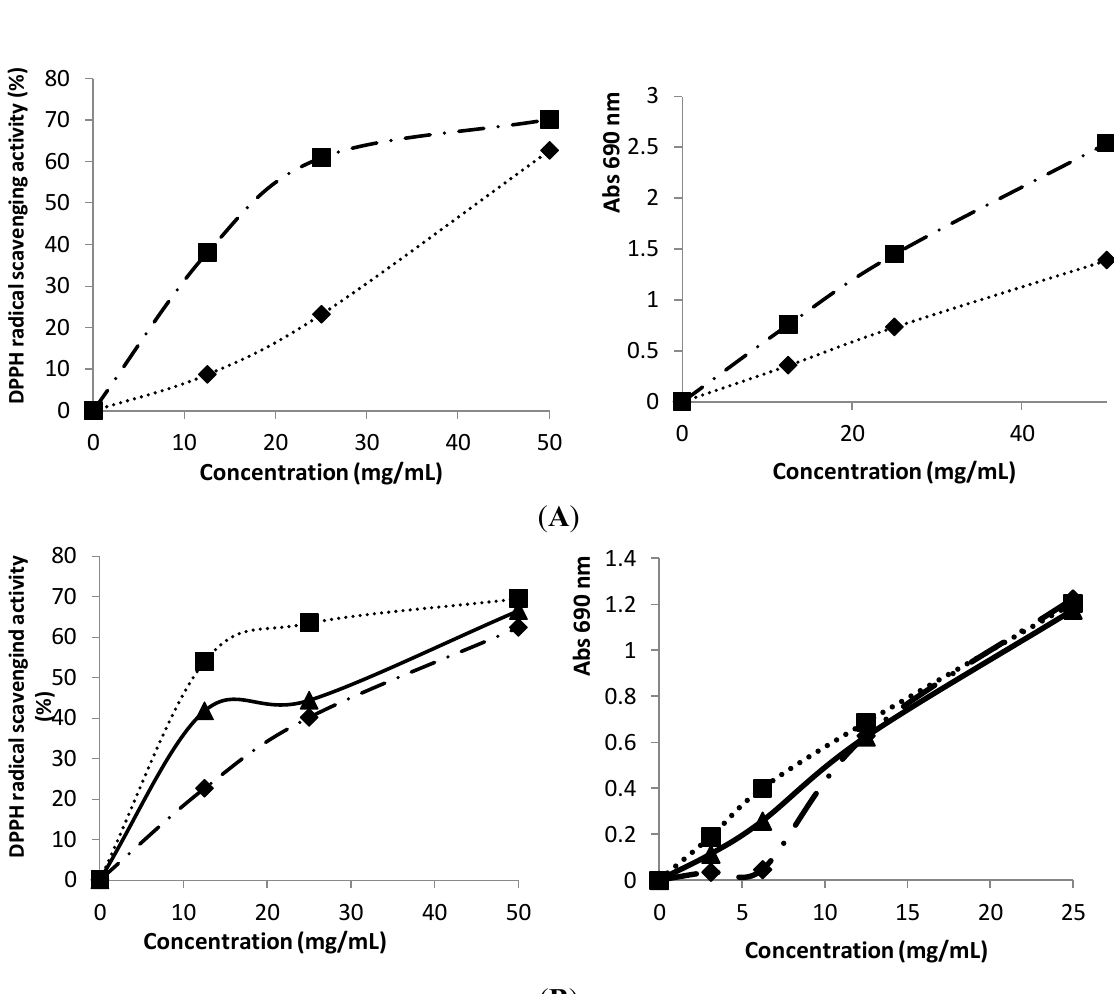
Figure 1. Comparison of 2,2-Diphenyl-1-picrylhydrazyl (DPPH) scavenging activity and reducing power between ( A ) blackberry and blackberry ―antioxidant‖ yogurts; ( B ) cherry and cherry ―antioxidant‖ Burlat and